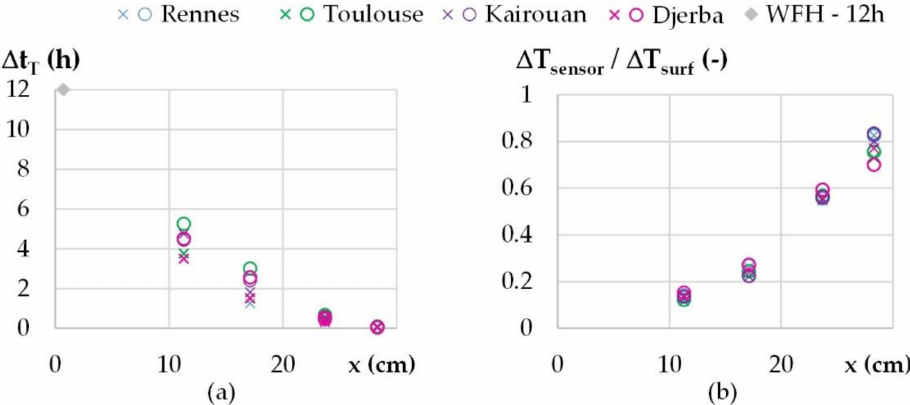
Figure 13. Dynamic thermal parameters versus location for all the cities ( × /o: calculated during increasing/decreasing temperature step): ( a ) Shift of temperature and theoretical value for a WFH layer of 28.8 cm, ( b ) damping factor.